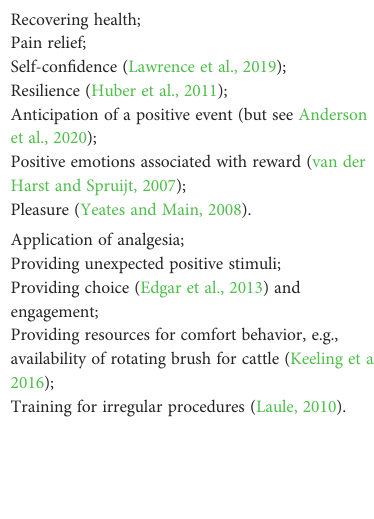
TABLE 1 Examples of appetitive and adverse internal and external factors and their potential lasting and sporadic consequences for animal welfare. Lasting impact/consequences Sporadic